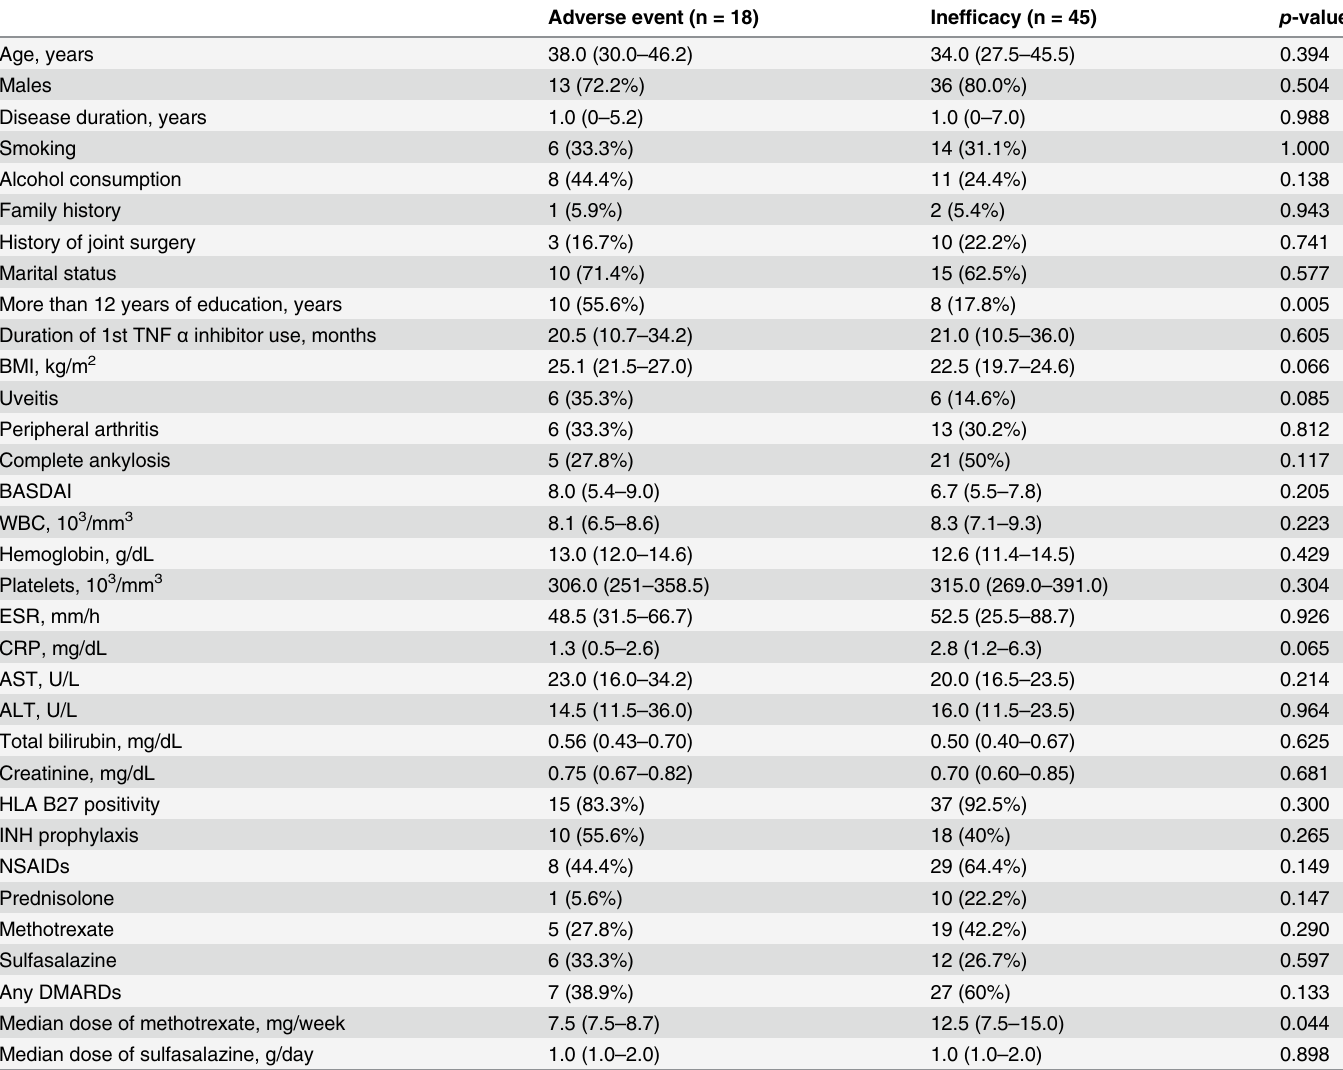
Table 3. Baseline characteristics of patients at the time of TNF- α inhibitor initiation according to the reason for subsequent